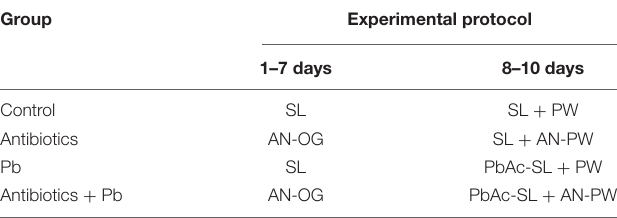
TABLE 1 | The protocol of animal experimental design I. Group